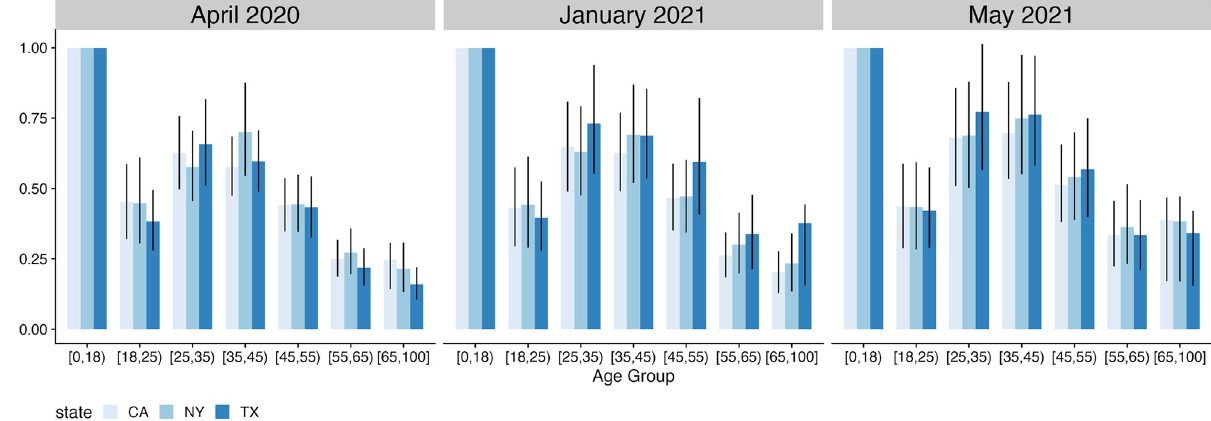
Fig 4. Relative contribution of each age-group to overall transmission in California, New York, and Texas assuming no age-specific differences in transmissibility or susceptibility. We pick the youngest age group [0–18) as a reference group which all other estimates are rescaled to. Error bars represent 80% credible